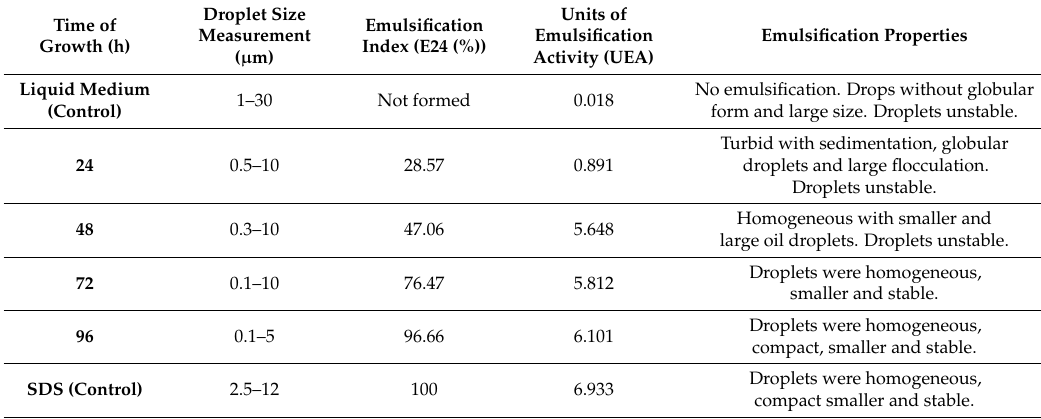
Table 2. Evaluation of the bioemulsifier produced by Candida lipolytica properties regarding droplet size, Emulsification index (E24), Units of Emulsification Activity (UEA) and characterization of emulsification *.